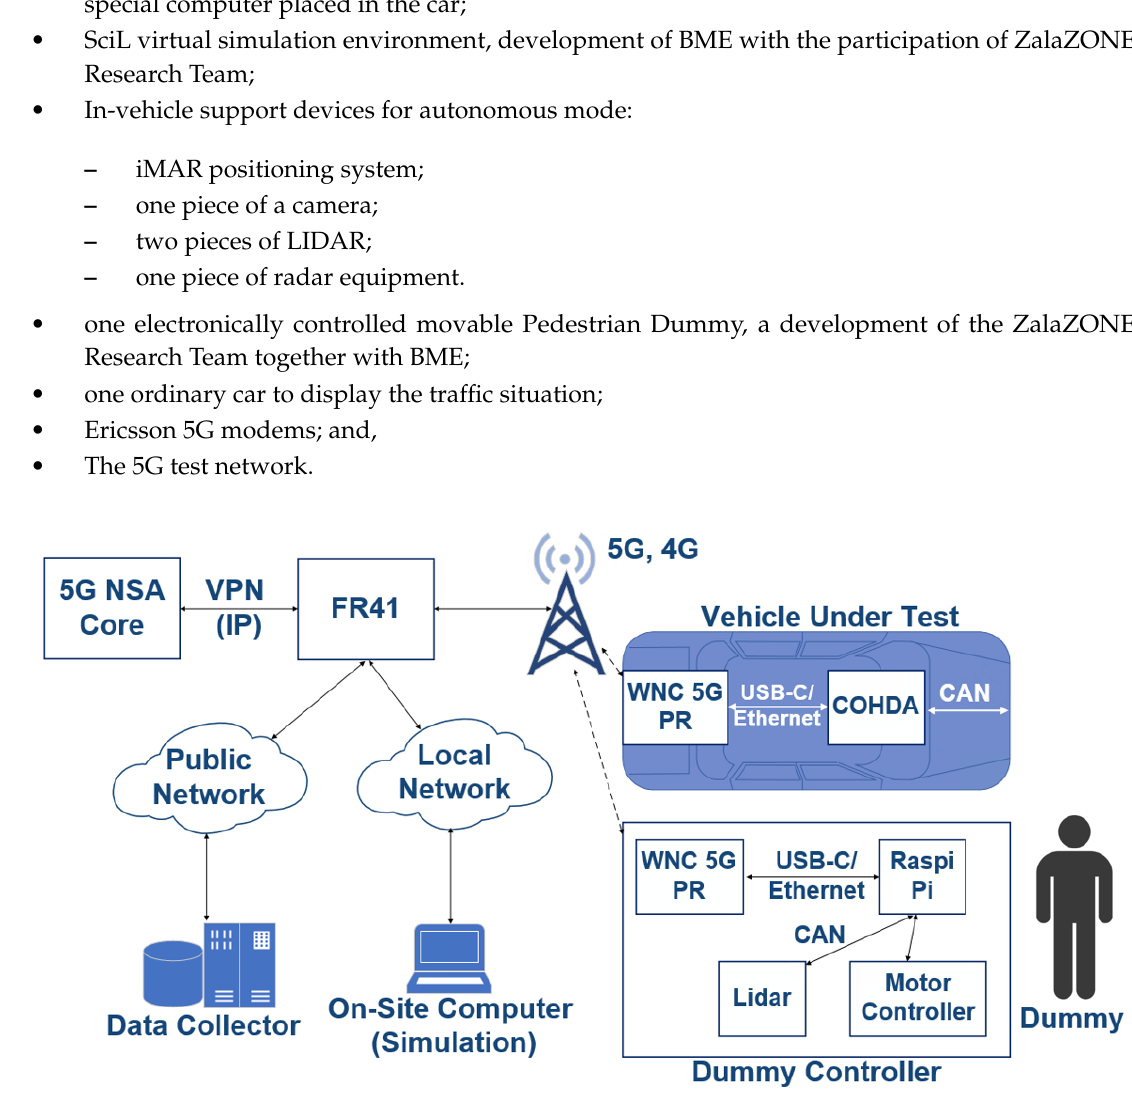
Figure 8. Communication architecture of the